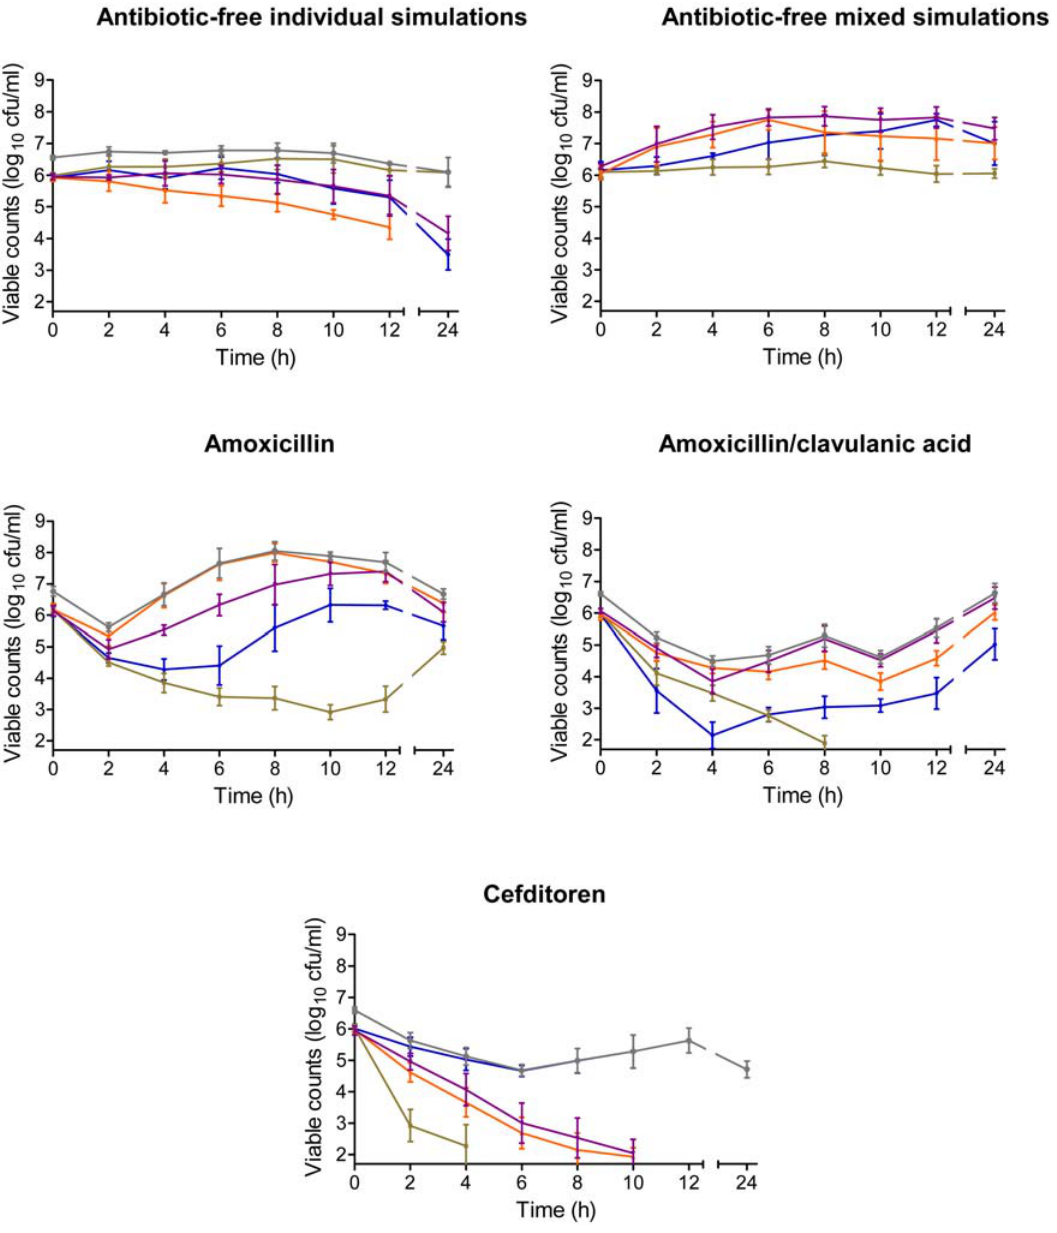
Figure 2. Evolution of inocula over time under experimental conditions. Colony counts over 24 h in antibiotic-free individual simulations, antibiotic-free mixed simulations and in simulations with study drugs (grey: total population, blue: S. pneumoniae , green: S. pyogenes , orange: BL + , purple: BLPACR).